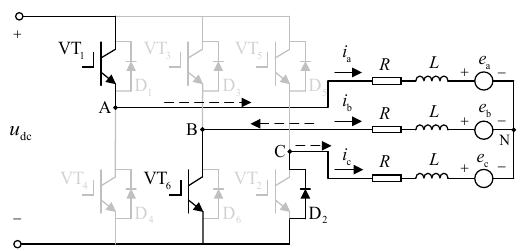
Figure 5. Equivalent circuit when commutation occurs from VT 5 to VT 1 .